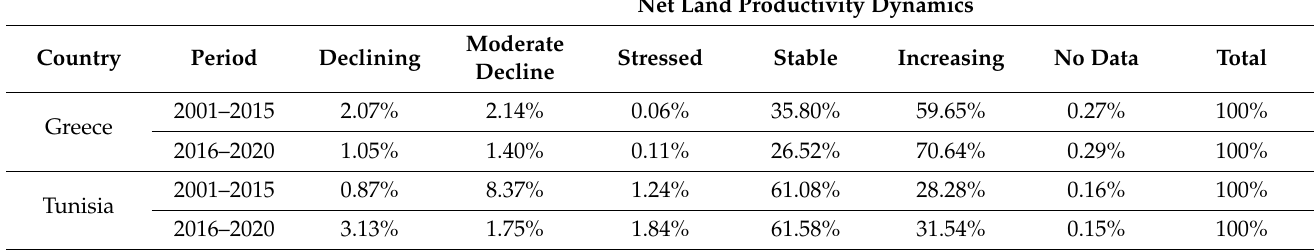
Table 3. Land productivity dynamics for the baseline and reporting periods in Greece and Tunisia for the croplands. Net Land Productivity